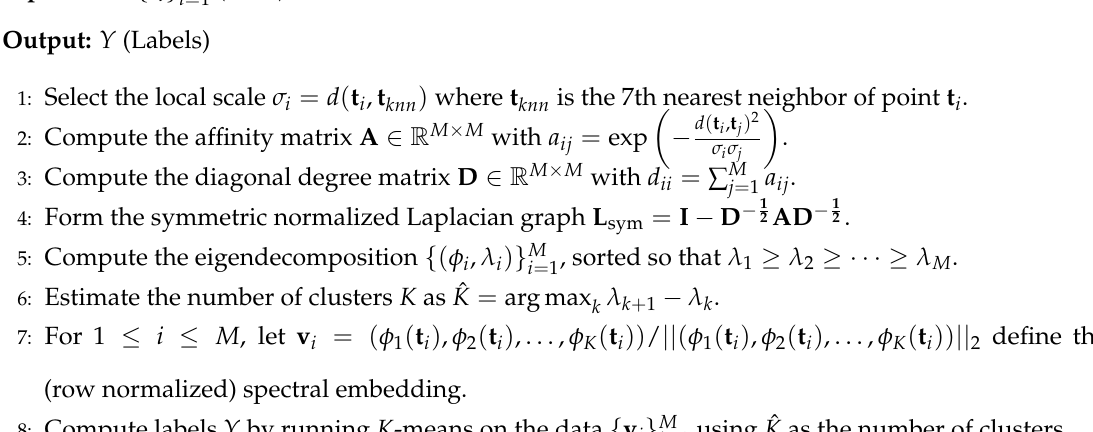
Algorithm 2 Spectral Clustering with metric d (Euclidean